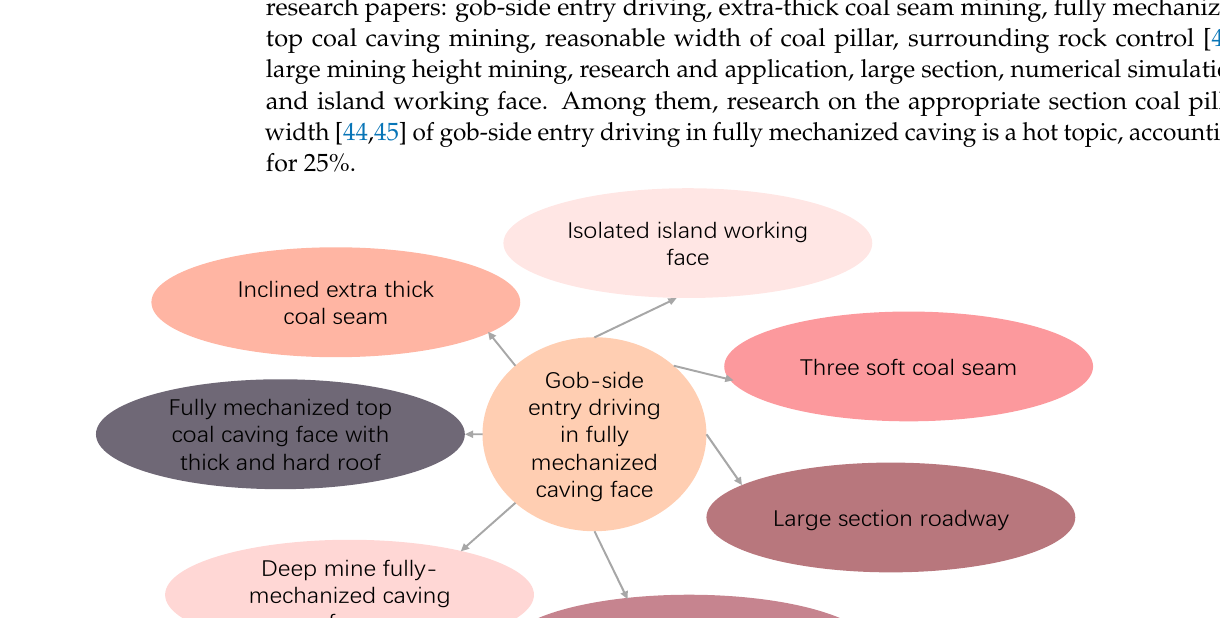
Figure 1. Some research directions of gob-side entry driving in fully mechanized caving mining.